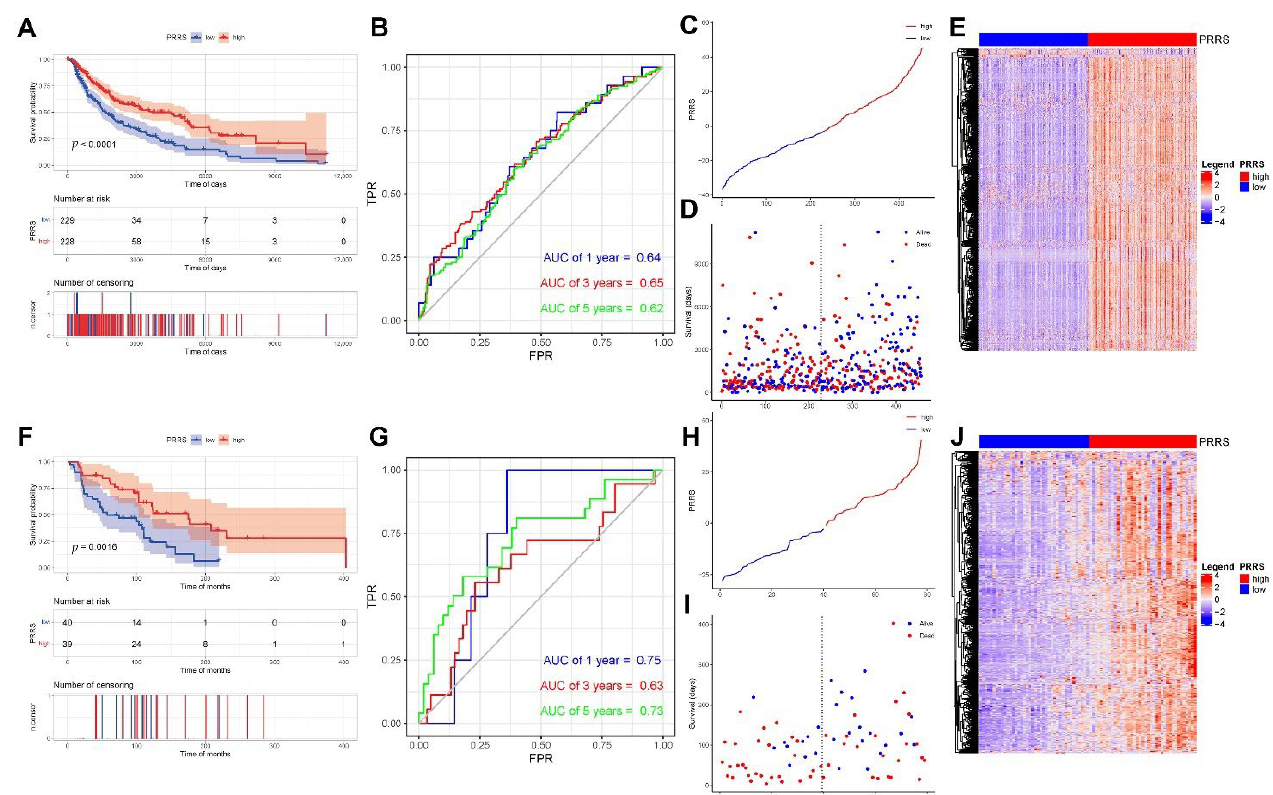
Figure 8. Phagocytosis regulator-related system (PRRS) construction. ( A – E ) Model effectiveness validation of PRRS for TCGA data. We performed univariate Cox regression based on DEGs in TCGA to screen 582 DEGs associated with survival and then performed PCA to obtain PRRS scores based on these genes. ( A ) Build model Kaplan-Meier curve validation. ( B ) Receiver operating characteristic (ROC) curve validation. The areas under the curve (AUC) were all greater than 0.6, indicating good model efficacy. ( C ) PRRS score graphs for all samples. ( D ) Scatter plot of survival time for all samples. ( E ) Heat map of gene expression in the model. ( F – J ) Model effectiveness validation of PRRS for GSE54467 data. ( F ) Build model Kaplan–Meier curve validation. ( G ) ROC curve validation. The AUCs were all greater than 0.6, indicating good model efficacy. ( H ) PRRS score graphs for all samples. ( I ) Scatter plot of survival time for all samples. ( J ) Heat map of gene expression in the